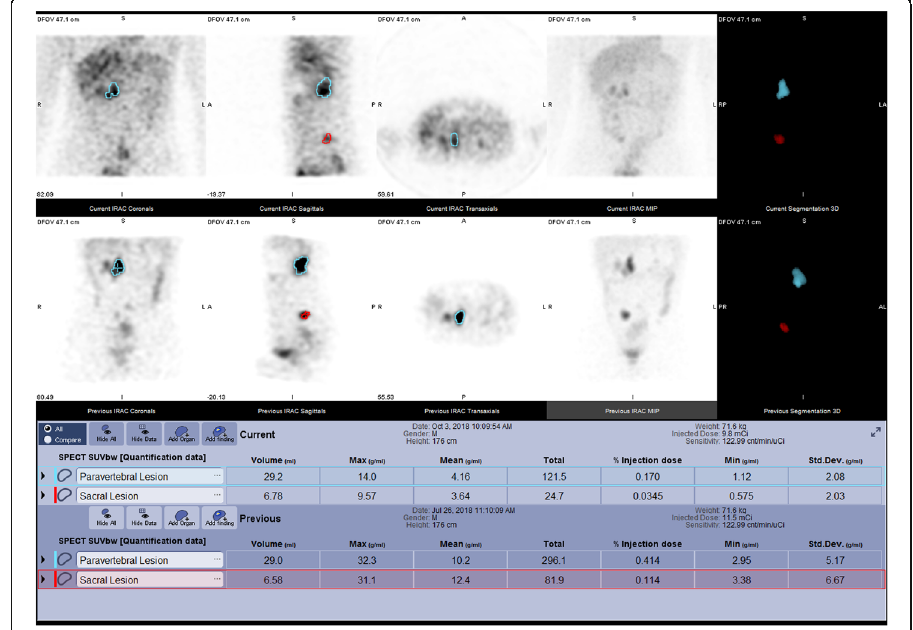
Fig. 1 Iodine-123 mIBG imaging of a 19-year-old male patient with relapsed neuroblastoma. The upper imaging and result panel are from a post-mIBG therapy study, while the lower imaging and result panel are from pre-therapy imaging. The data from post therapy imaging shows a clear quantitative metabolic response in paravertebral and sacral lesions